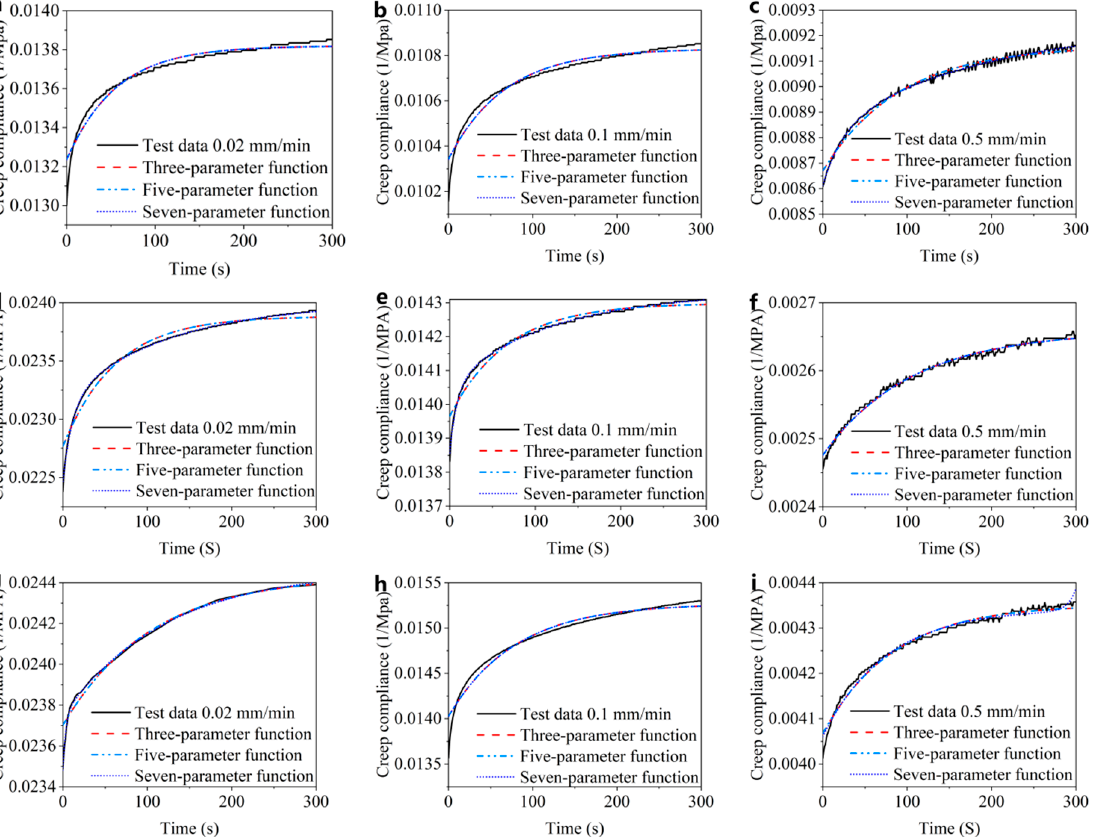
Figure 14. The fitting curves of three viscoelastic models. ( a – c ) Fitting curve of sample 1 at different rates; ( d – f ) fitting curve of sample 2 at different rates; ( g – i ) fitting curve of sample 3 at different rates.